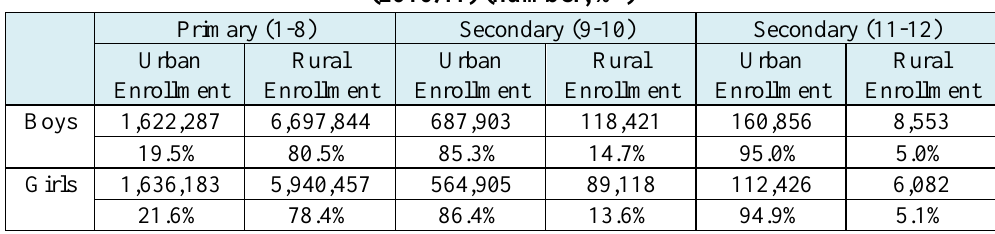
Table 4-8: Primary and Secondary Enrollment and Percentage by Urban/Rural Area (2010/11) (number, %) Primary (1-8) Secondary (9-10) Secondary (11-12) Urban Rural Urban Rural Urban Rural Enrollment Enrollment Enrollment Enrollment Enrollment Enrollment Boys